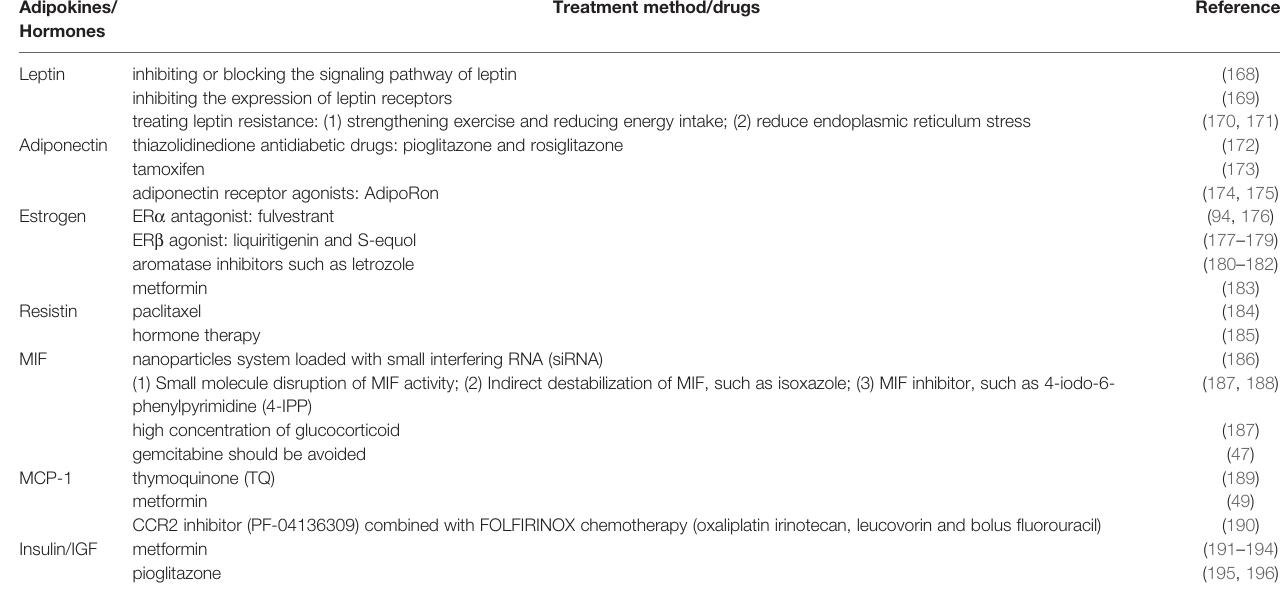
TABLE 2 | Summary of Treatment